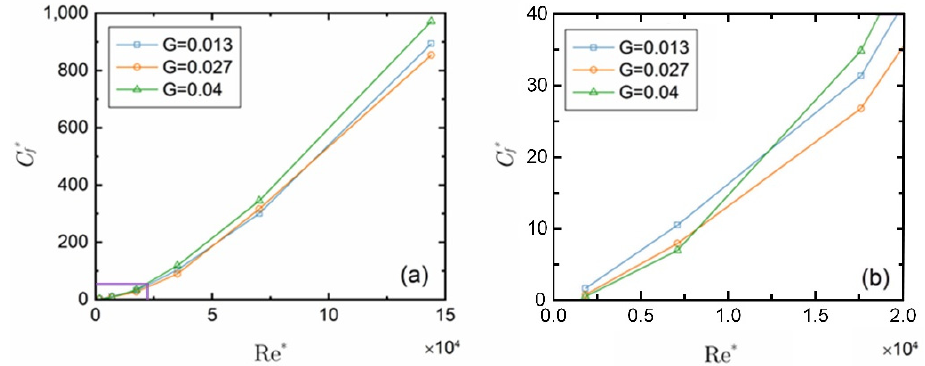
Figure 9. Change of the skin friction coefficient of the rotor with Re : ( a ) Overall view; ( b ) Partial enlarged view.